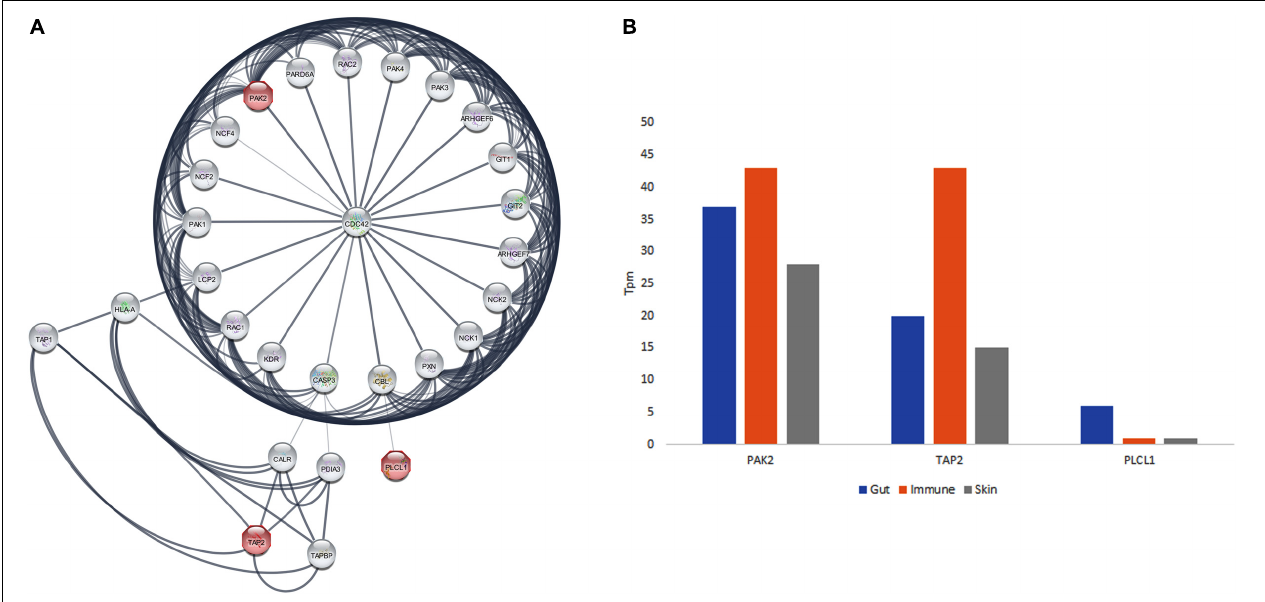
FIGURE 3 | The protein interaction network of PAK2, TAP2 , and PLCL1 and GTEx database expression analysis in gut, immune and